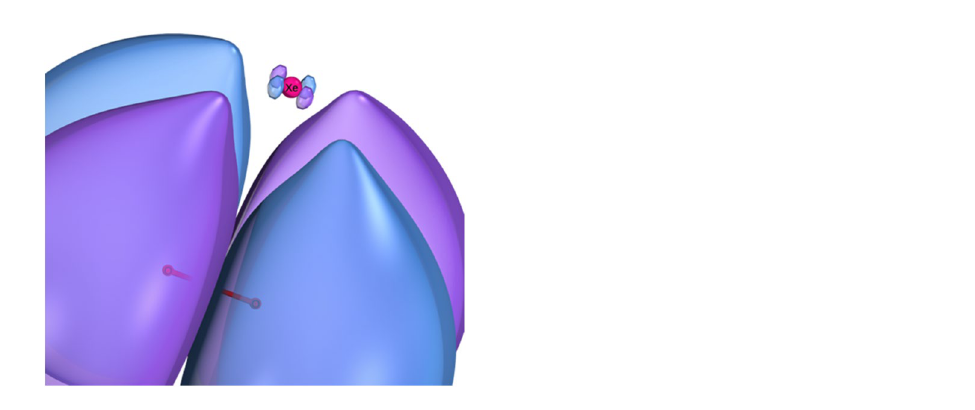
Figure 10. The highest occupied molecular orbital (HOMO) of Xe–O ·− 2 . Image generated using IboView v20150427 (http:// www. ibovi ew.